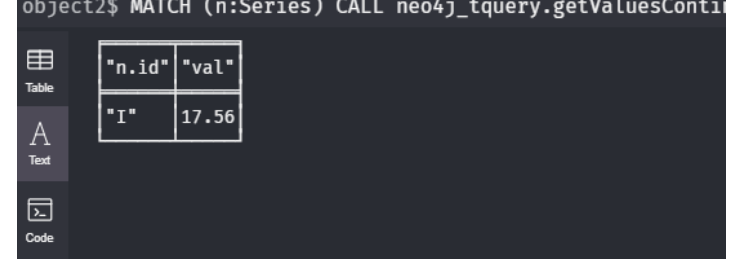
Figure 8. Visualization of the output of query Q 4 run on the sensor network of Figure 4. The result is taken from the web interface of